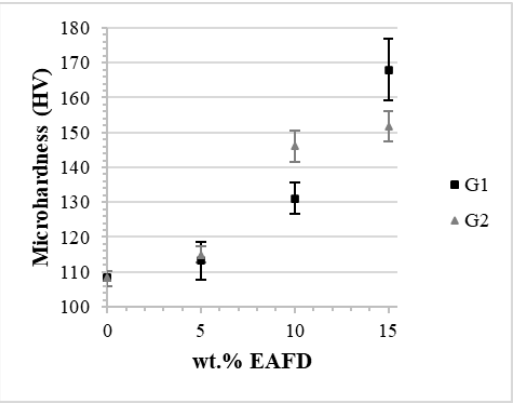
Figure 9. Vickers microhardness of G1, G2, and AA7075 samples vs. EAFD content.